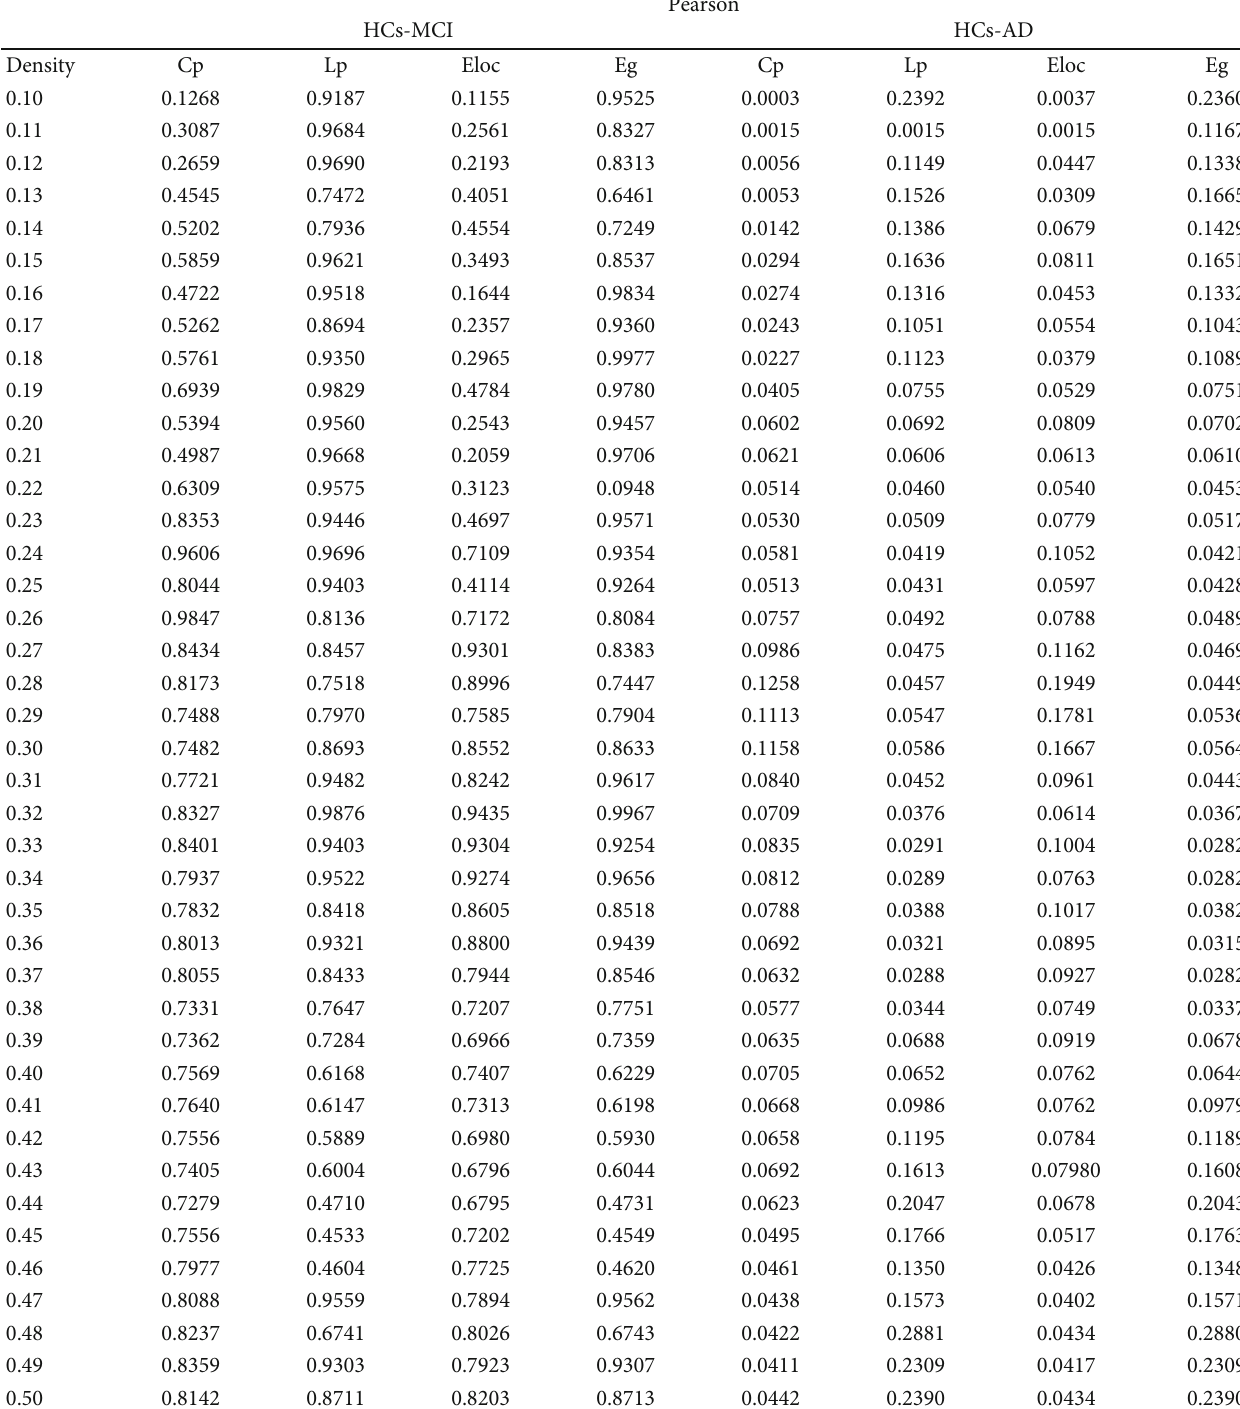
Table 3: P values of statistical tests on the small-world parameters using the Pearson